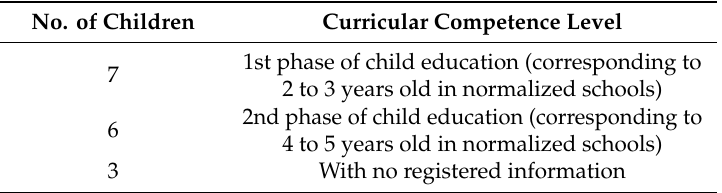
Table 4. Curricular competence level of